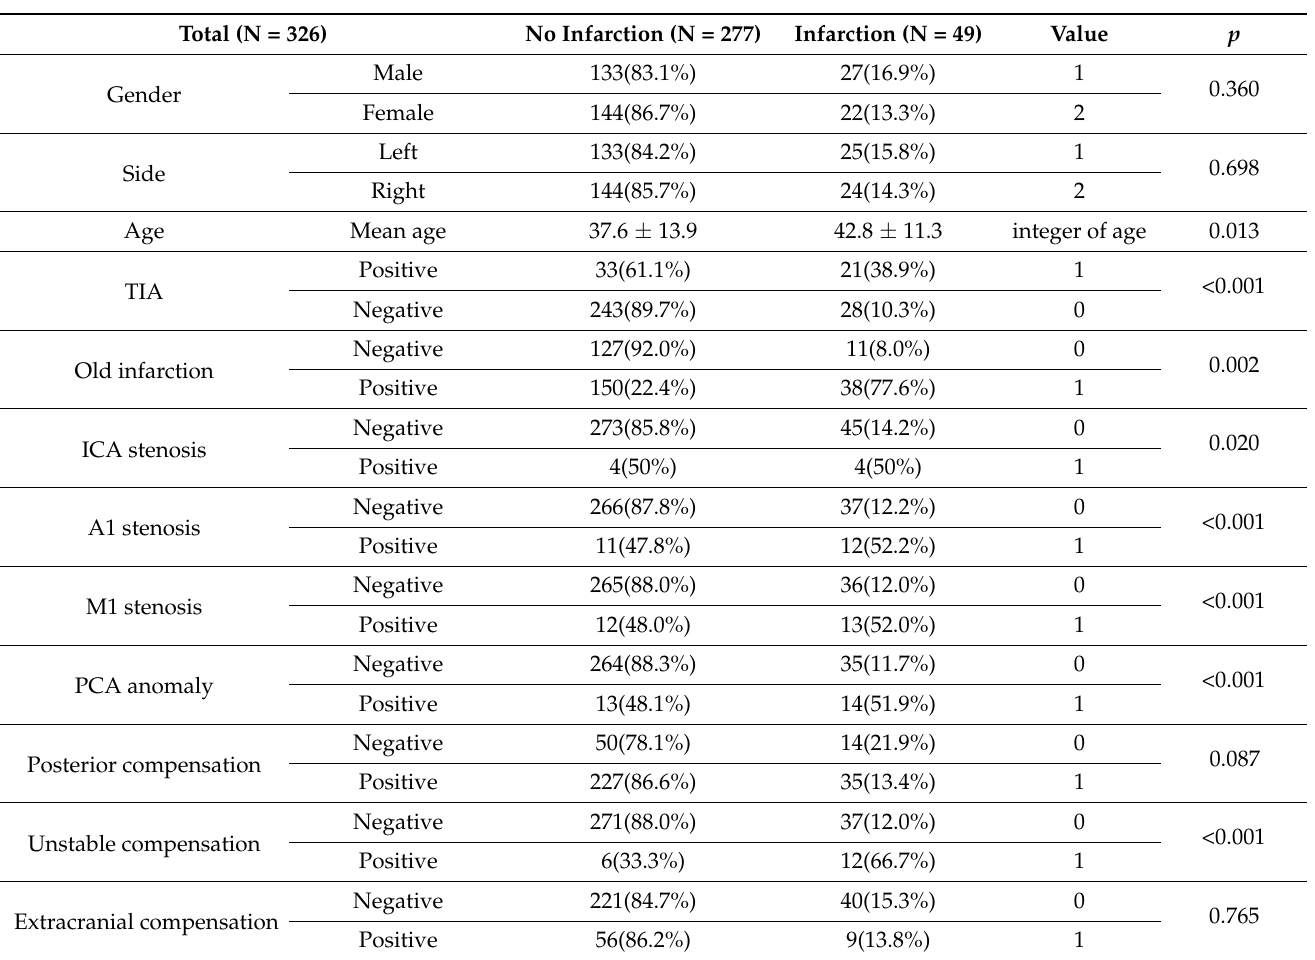
Table 1. Single-factor analysis